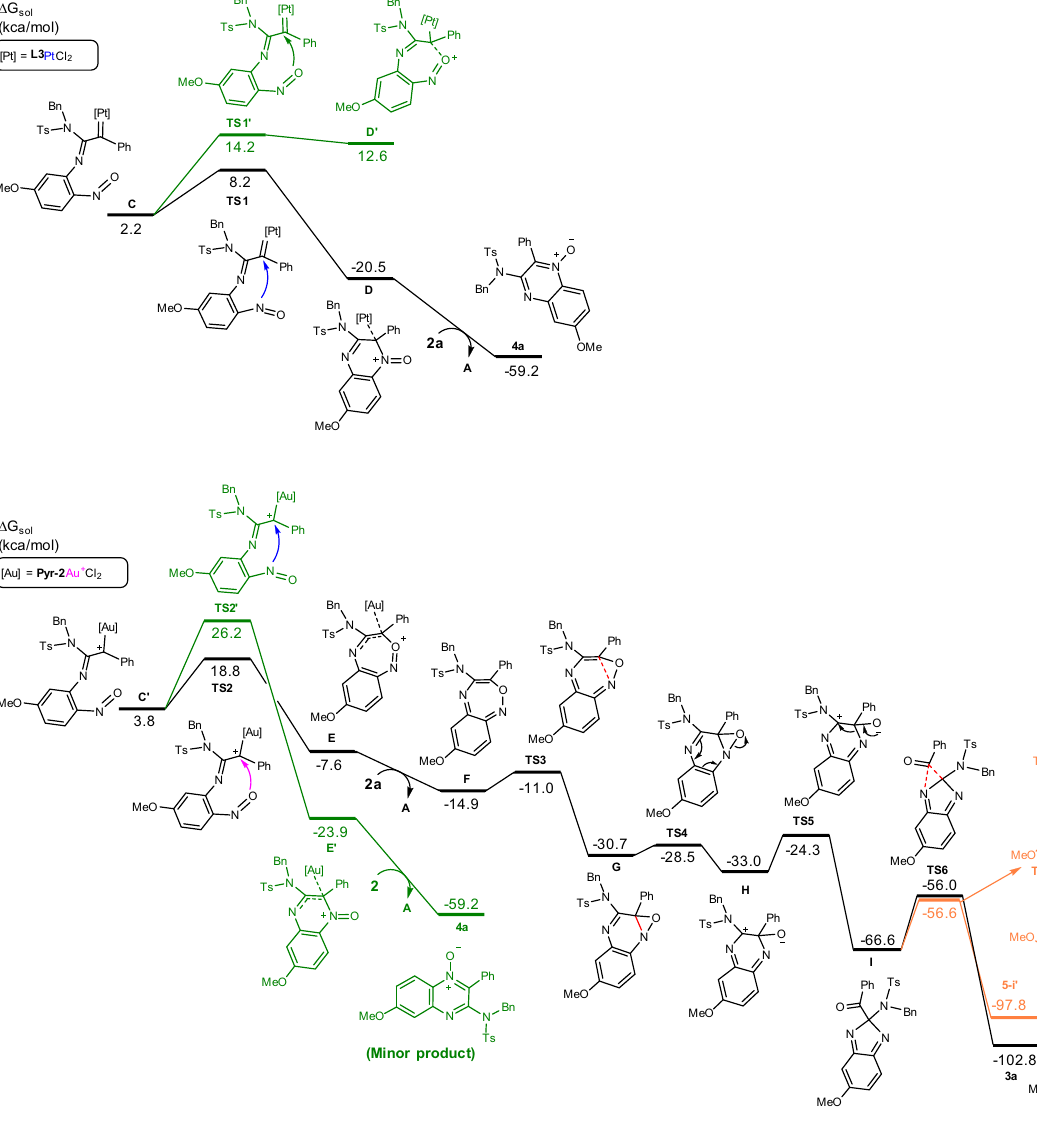
Fig. 8 Mechanism investigation by computational calculations. Calculated free energy pro fi le of the Pt(II) and Au(III)